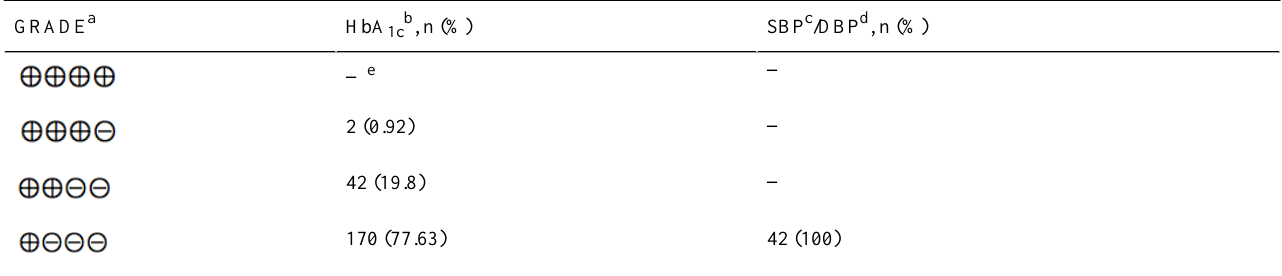
Table 6. Grading of Recommendations, Assessment, Development, and Evaluation assessment of certainty of glycated hemoglobin and systolic blood pressure/diastolic blood pressure